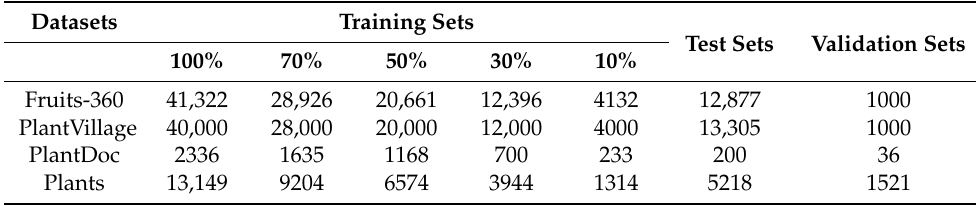
Table 10. Detailed explanations of train and test sets used in our experiments. Datasets Training Sets